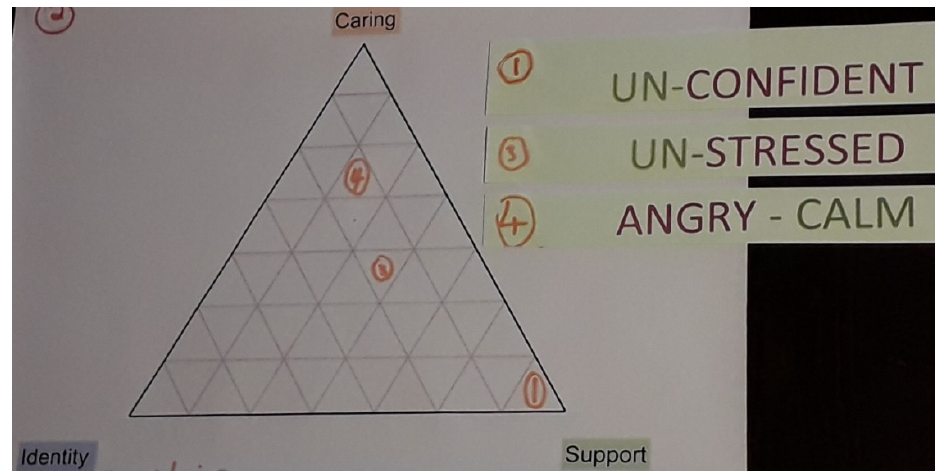
Figure 2. Martin’s frustration (impact 4) increased as a transitioning young carer.